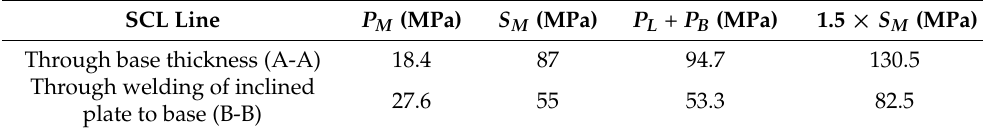
Table 1. Primary stresses in the SCL lines of the TLIC door (Al 6061 T6). SCL Line Through welding of inclined plate to base (B-B)